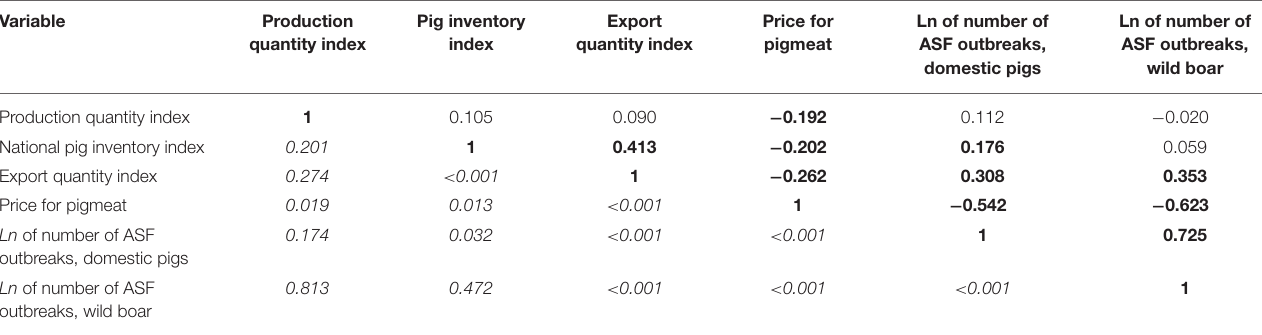
TABLE 3 | Pearson correlation coefficients (upper triangle, in roman style) and their p -values (lower triangle, in italics) of market parameters and the number of ASF outbreaks in the